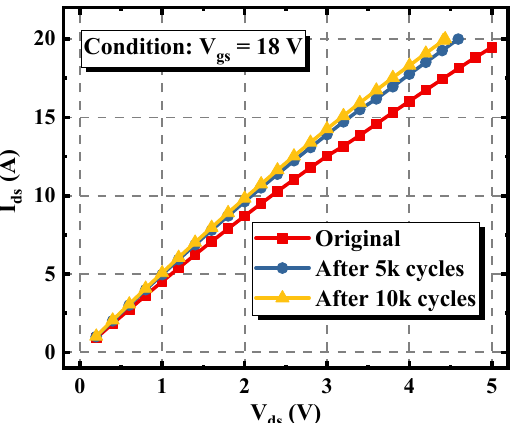
Figure 8. Variations of the I d -V d characteristic at V gs = 18 V of the double-trench SiC MOSFET under different avalanche stress cycles.